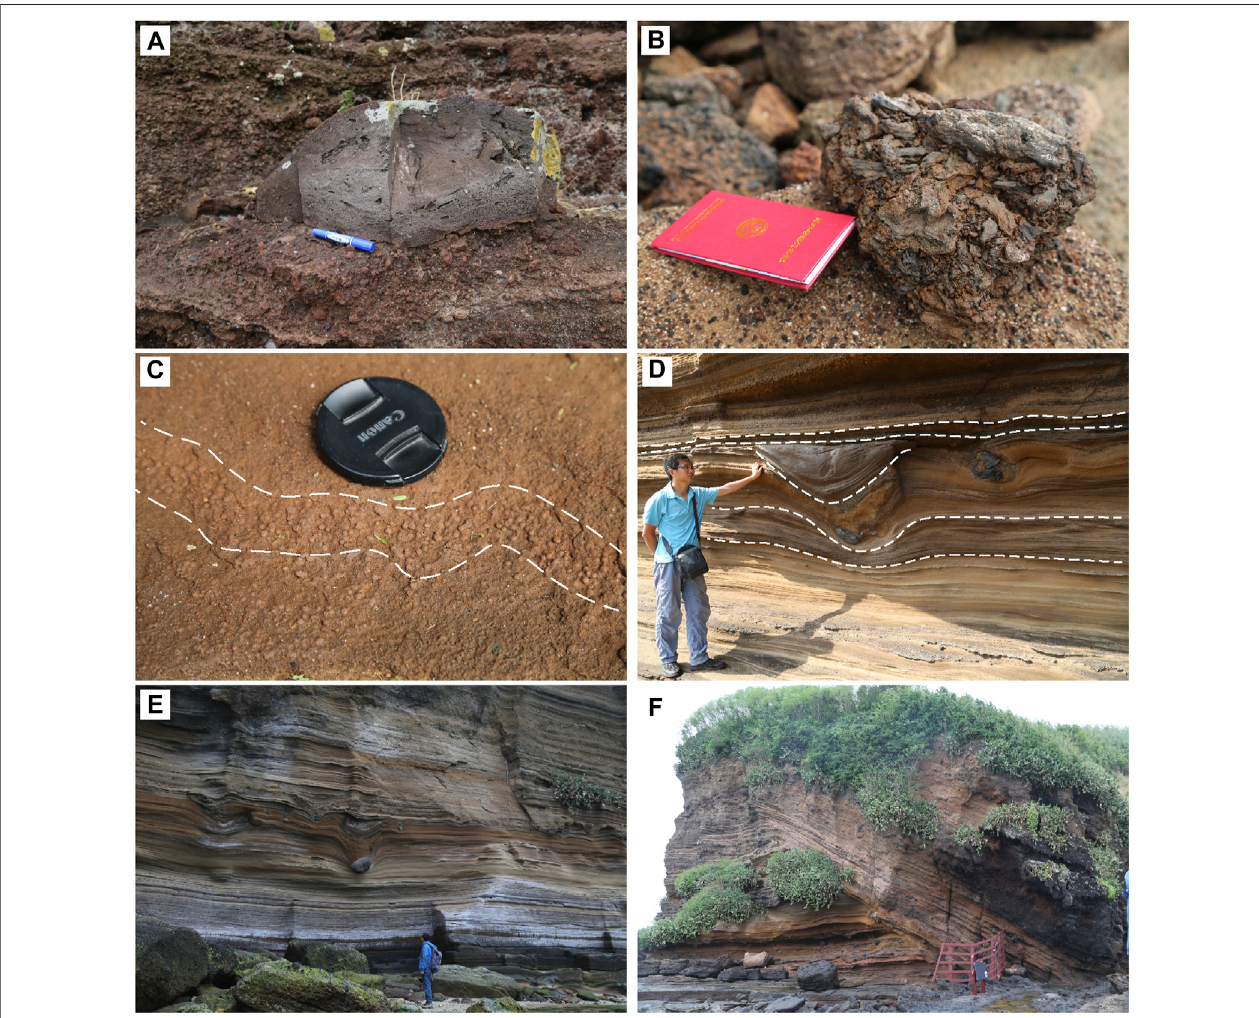
FIGURE6| FieldphotographsofNanwanvolcanodeposits. (A) Volcanicbombinbrick-redspatterdepositsinsidethecraterwallsofNanwanVolcano. (B) Welded breccias on the eastern side of Zhuzai island. (C) Outcropping accretionary lapilli at the bottom of the PDCs deposits at Eyuzui; Accretionary lapilli are spherical aggregates of volcanic ash, commonly having a concentric structure and formed by clumping of moist ash (Yan et al.,2008; Sigurdsson et al., 2015). (D) Bomb sag structure near Dishui, where volcanic bombs fell into the underlying plastic layer and created cratered surfaces. (E) Thick PDCs deposits and bomb sag structure. (F) Climbing structure at